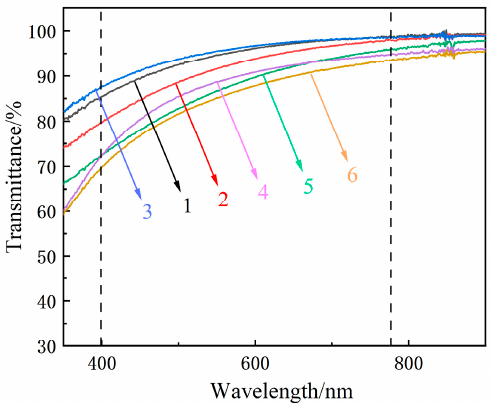
Figure 5. Optical transmittance of the Si-B-C-N/DLC gradient films; the visible wavelength range is within the two dashed lines.